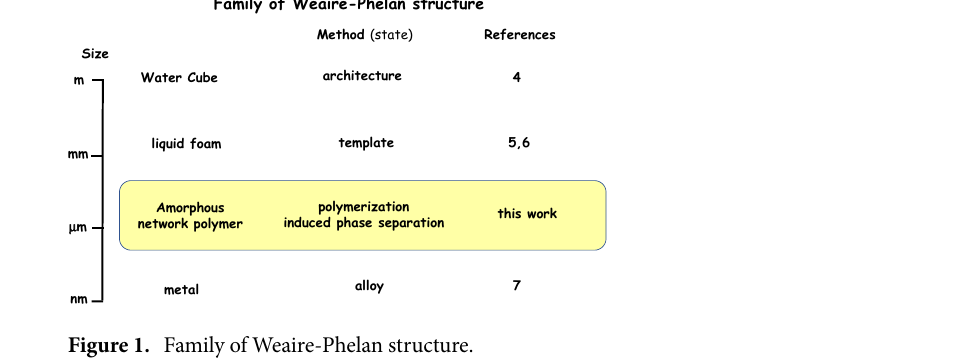
Figure 1. Family of Weaire-Phelan structure.